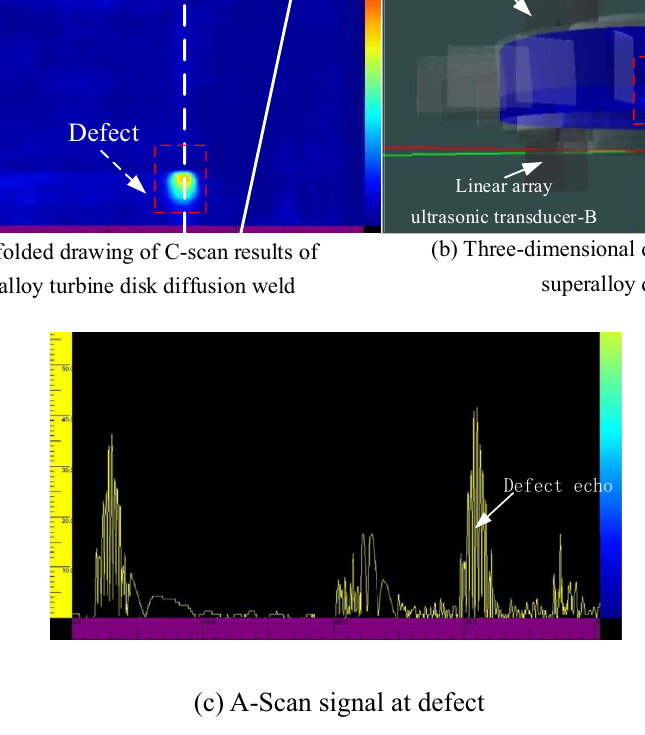
Figure 17. The detection results of the superalloy turbine disk sample using the dual array